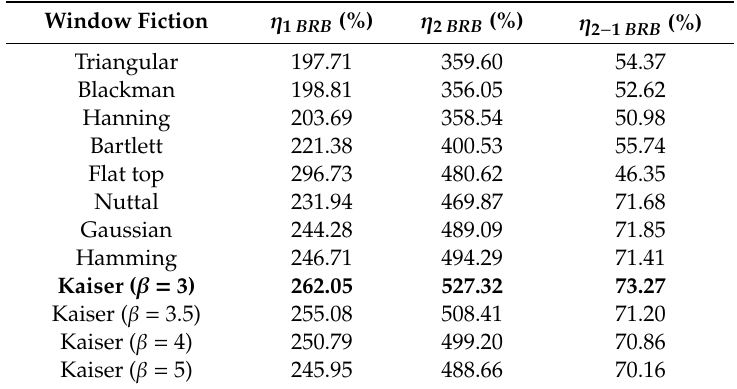
Table 4. The types of window function and their BRB fault identification capabilities in the